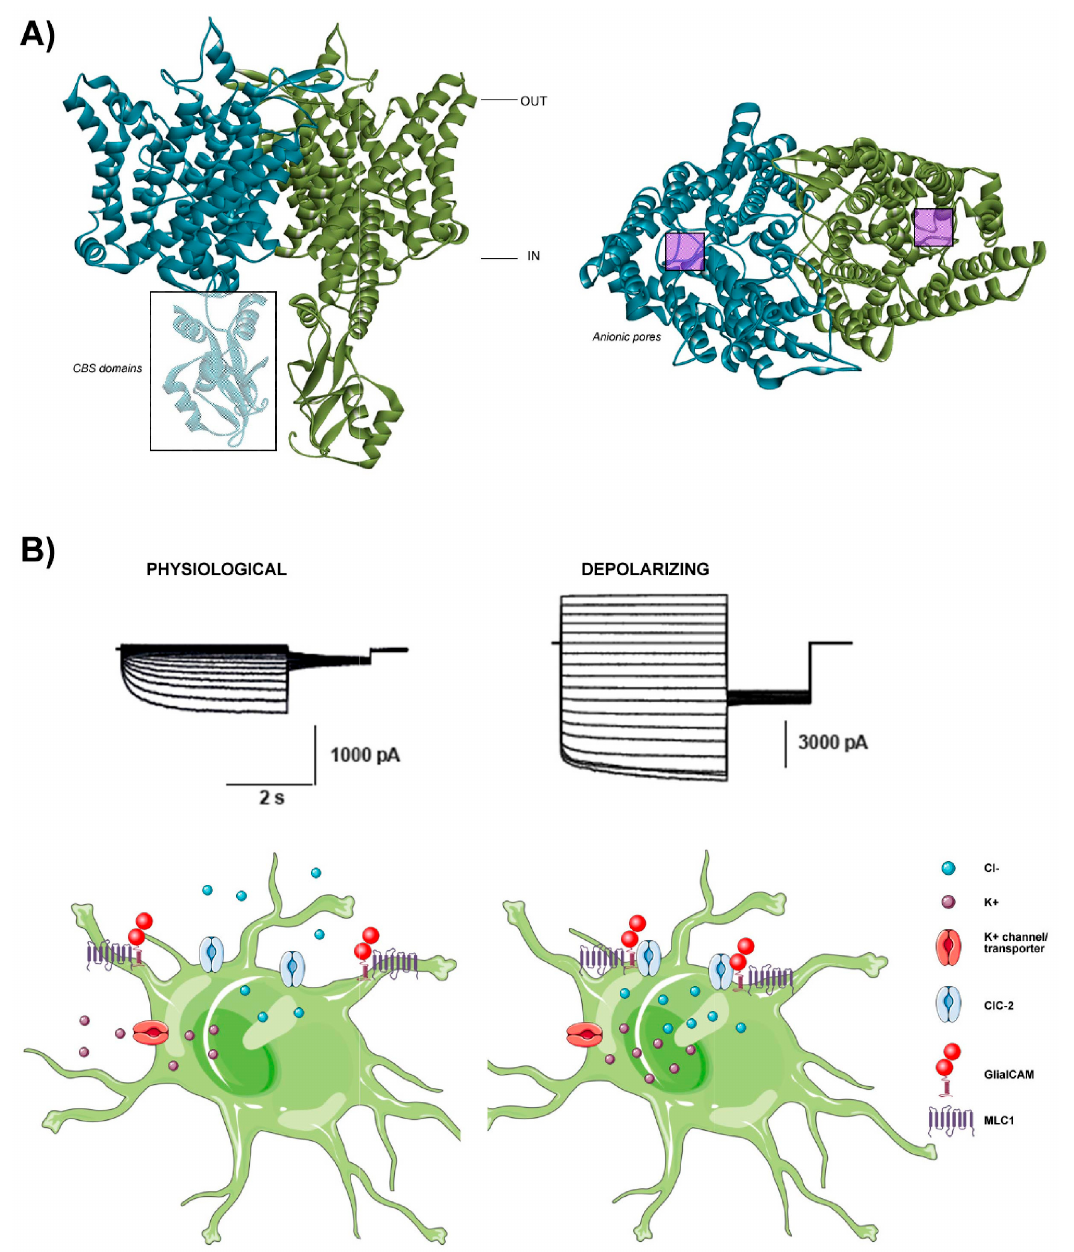
Figure 1. The chloride channel ClC-2. ( A ) The structural configuration of a CLC chloride channel. (Left) Lateral view of the dimeric form of the channel, which is comprised of two subunits distinguished by different colours. The intracellular cystathionine- β -synthase (CBS) domains are also highlighted in the unshaded box. (Right) Frontal view of the dimeric channel, where the two pores are highlighted in the purple boxes. Figures generated using the PDB model 5TQQ from human ClC-1, which has high homology to the ClC-2 channel. ( B ) Proposed model for depolarizing-mediated ClC-2 activation by MLC1/GlialCAM in astrocytes. In basal conditions, ClC-2 displays outwardly rectifying currents, promoting Cl − efflux (left). Upon depolarization and the consequent entrance of K + into the cell, the MLC1/GlialCAM complex binds to ClC-2, allowing GlialCAM to modify ClC-2-mediated currents, generating a Cl − influx into the cell that may compensate the excess of K + (right).